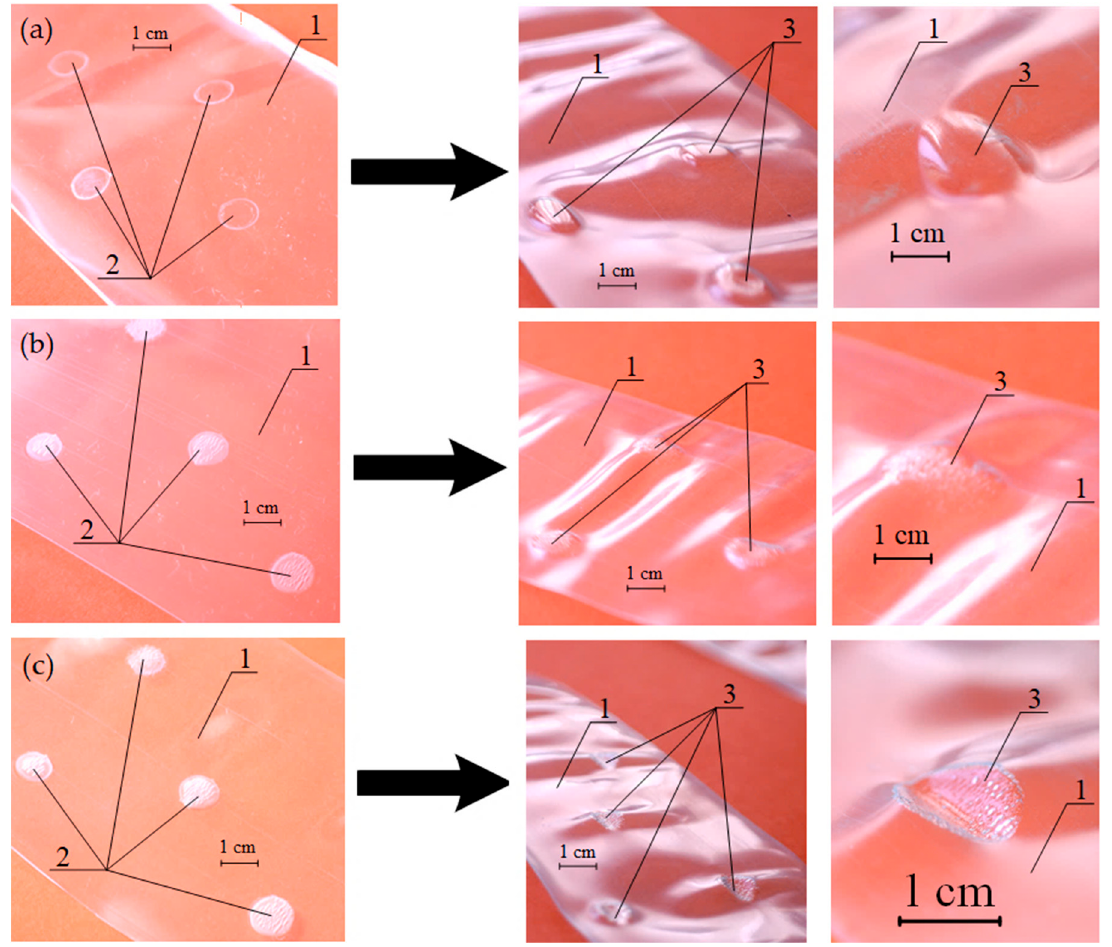
Figure 6. PVC films with hidden reliefs before and after heat treatment in a 30% THF solution at ( a ) 22 ± 1 °C; ( b ) 36 ± 1 °C; ( c ) 65 ± 1 °C. 1—shrink wrap, 2—hidden marking, 3—tactile (embossed) markings. Table 1. Change in the mass of PVC film after one-sided contact with an aqueous THF solution. THF Aqueous Solution Concentration, Parameters